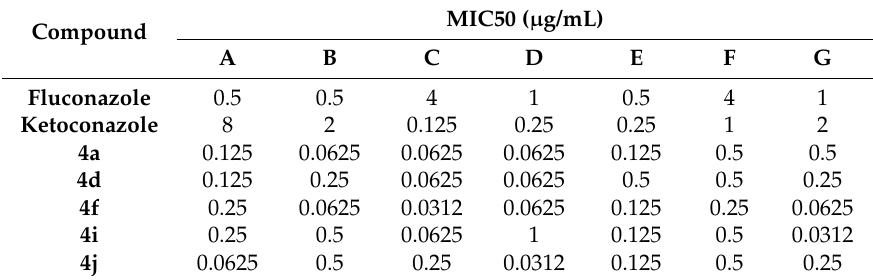
Table 4. Antifungal activity of compounds 4a , 4d , 4f , 4i , and 4j against the Candida species.